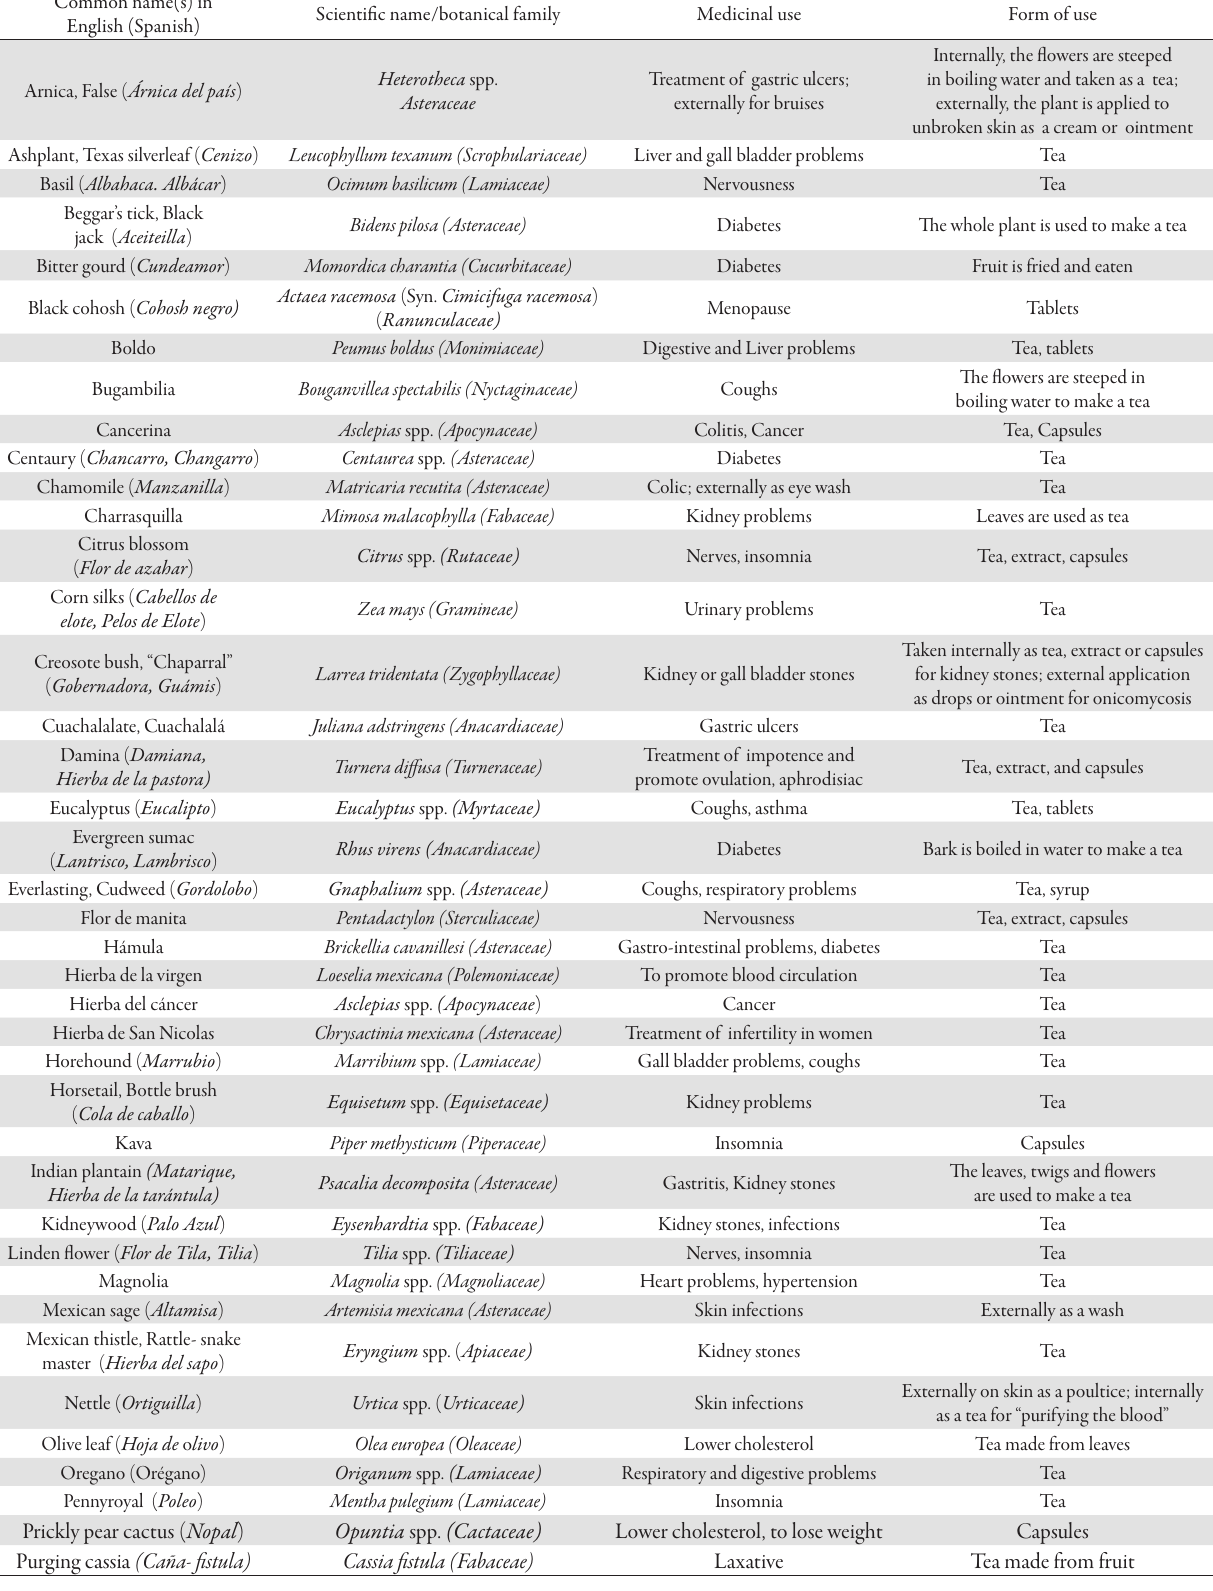
Tab. 1. Medicinal plants used to treat diverse ailments in